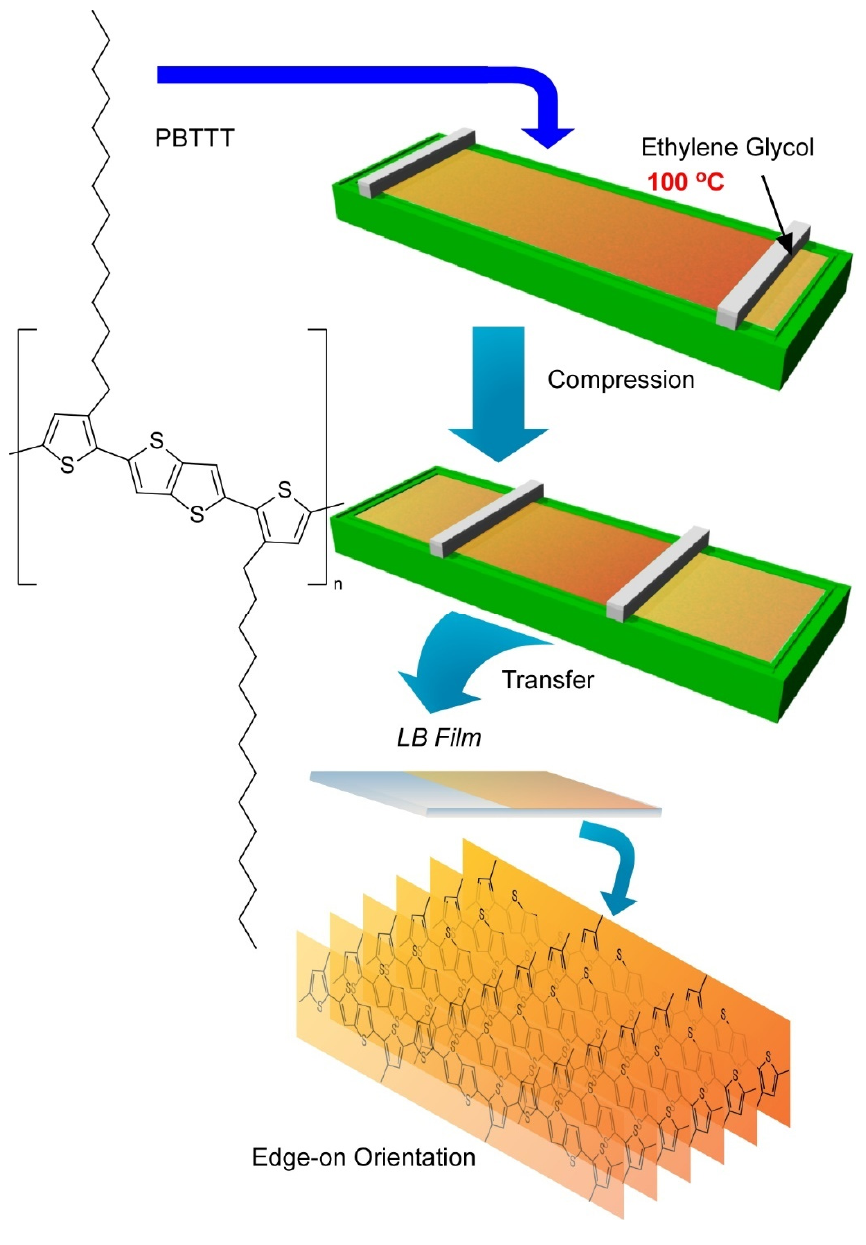
Figure 17. A novel method, 100 °C-Langmuir-Blodgett (100-LB) technique to fabricate highly ori- ented uniform ultrathin films with edge-on orientation of polymeric semiconductors, poly[2,5-bis(3-tetradecylthiophen-2-yl)thieno(3,2-b)-thiophene] (PBTTT), on ethylene glycol as a solvent for subphase.